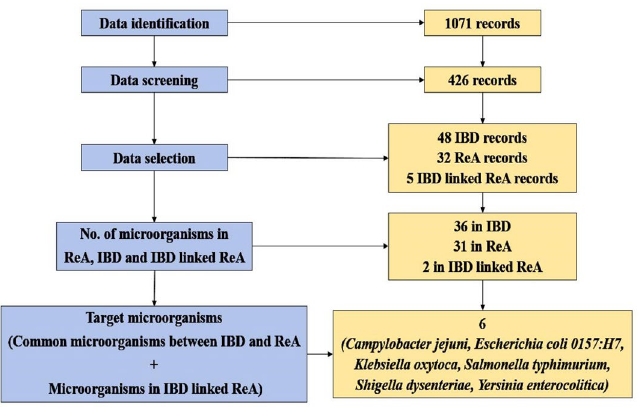
Figure 2. Target microorganisms for IBD co-evolved ReA obtained after text mining.